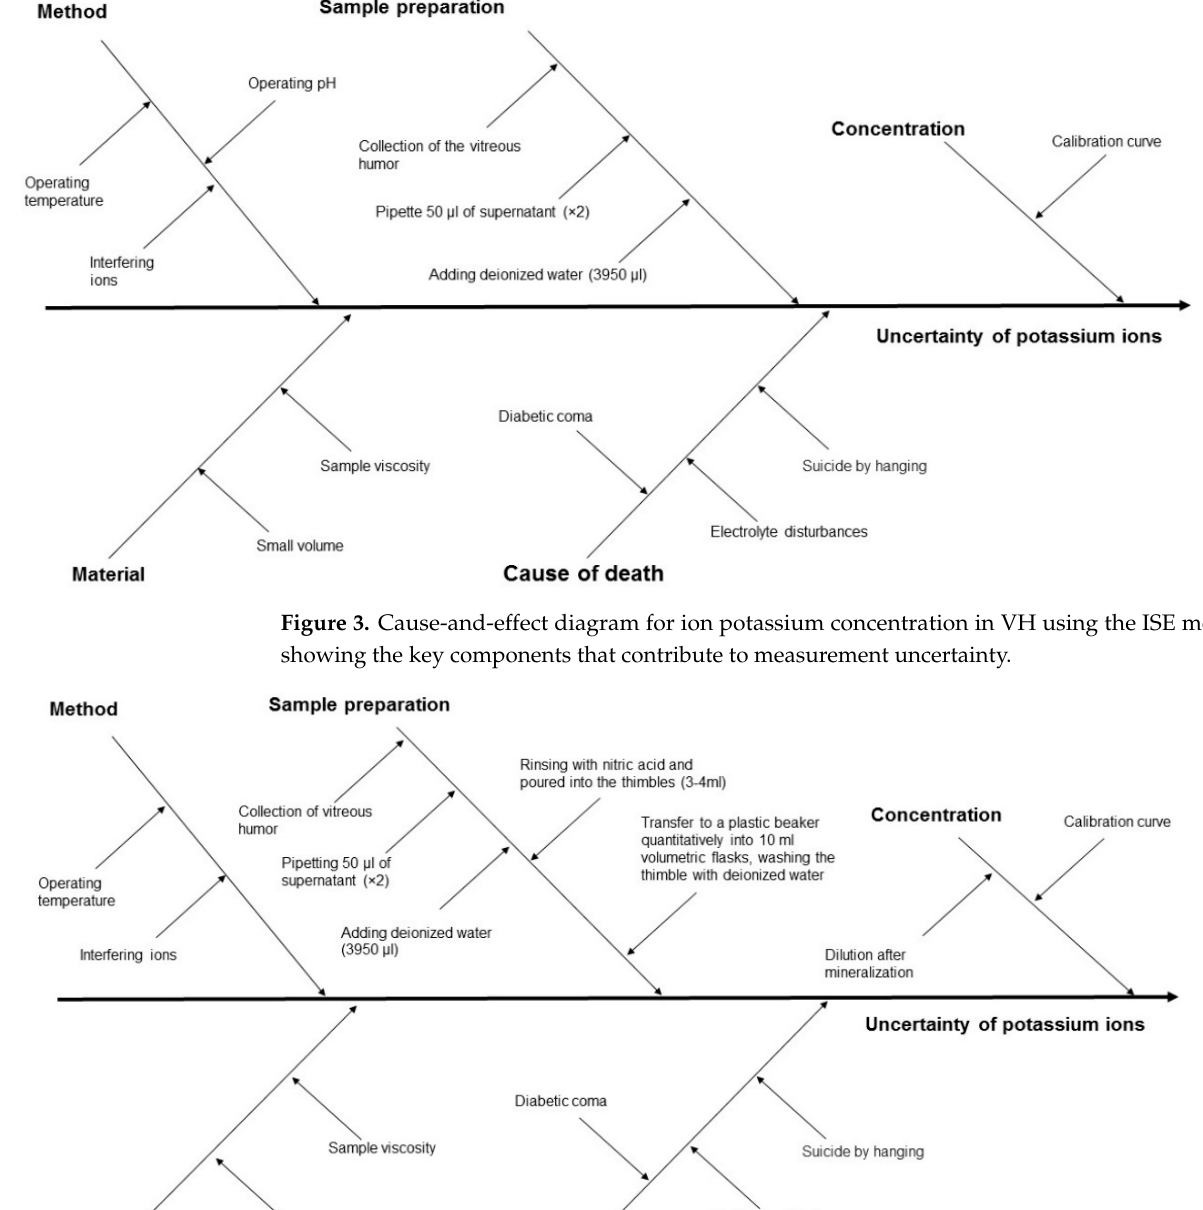
Figure 2. Calibration curves for the determination of potassium ion concentration by the MIP-OES